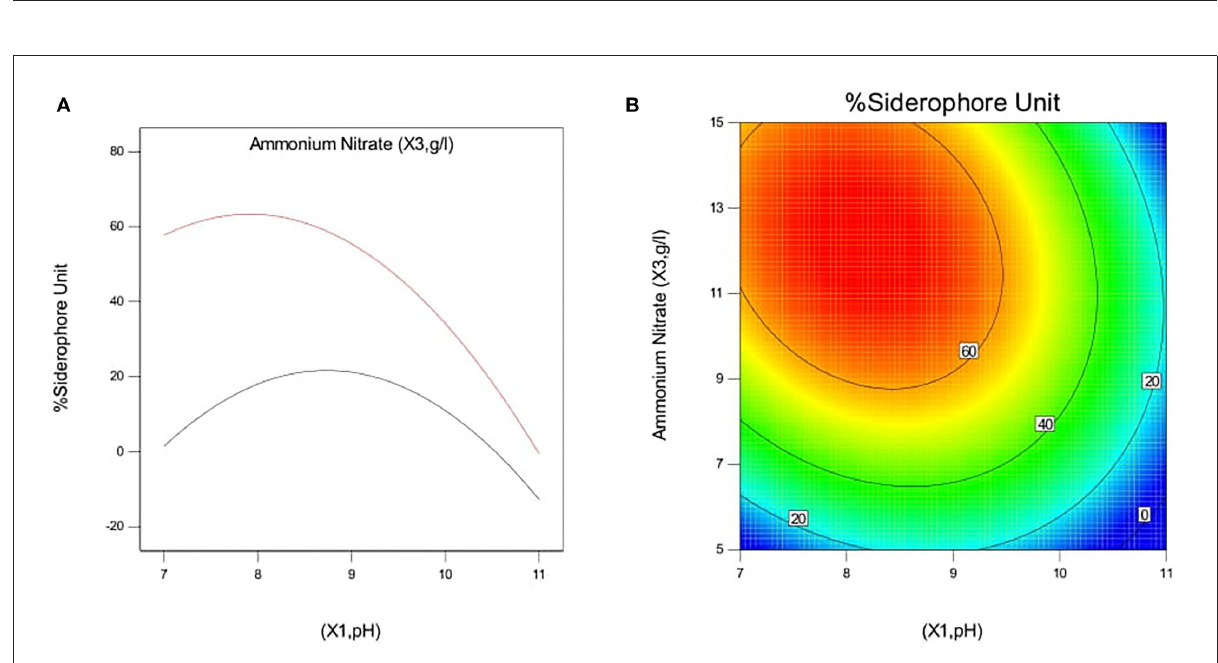
FIGURE5 Effect of pH and ammonium nitrate on siderophore production In isolate B8 at optimized condition of iron concentration (X2, 15 µ M). (A) Interactive and (B) contour.